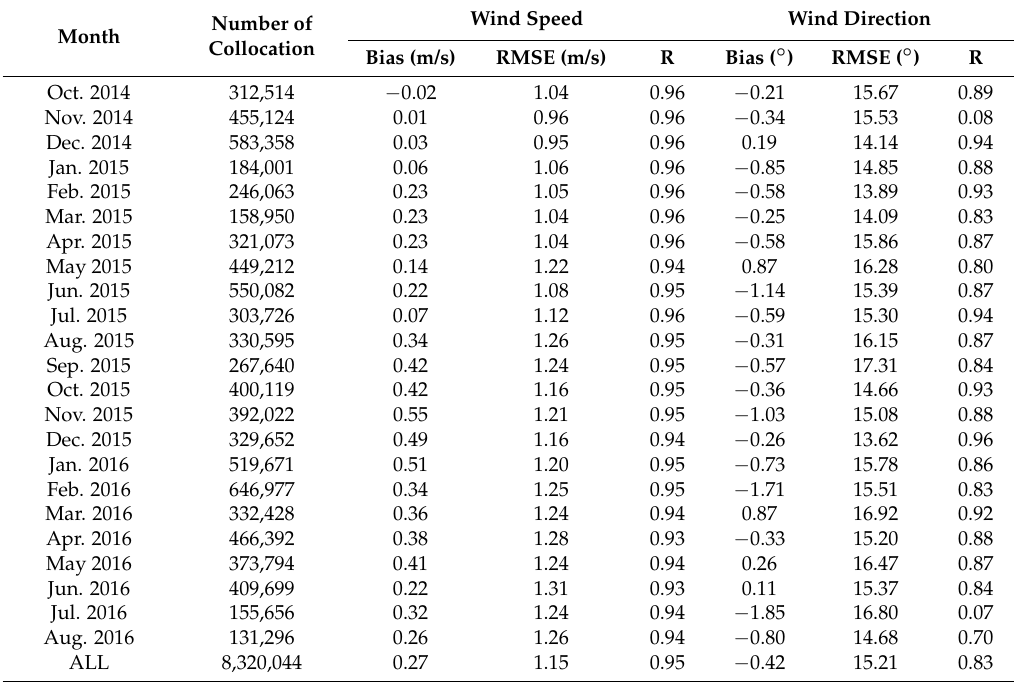
Table 3. The statistics of the differences between the RapidScat and ASCAT A and B wind data.